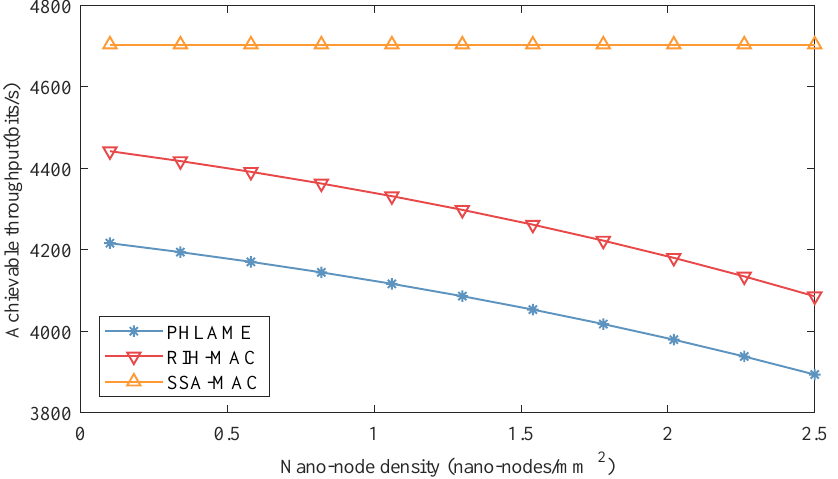
Figure 12. Achievable throughput of different MAC protocols as a function of nano-node density in distributed nano-networks.